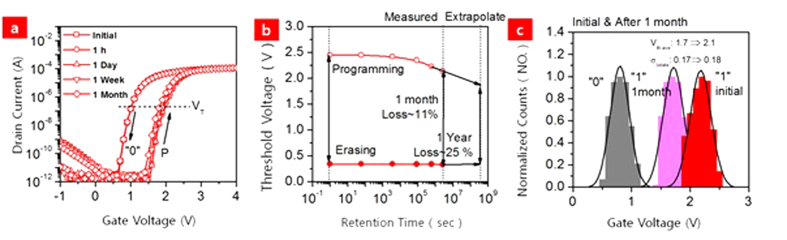
Retention characteristics of SNLC-PZT FeFET.(a) Transfer curves as a function of retention time at 0.1 V of drain voltage. (b) Distribution of threshold voltage in erase and program state at initial and after 1 month. (c) Retention time test respect to the threshold voltage and its extrapolation to 1 year.